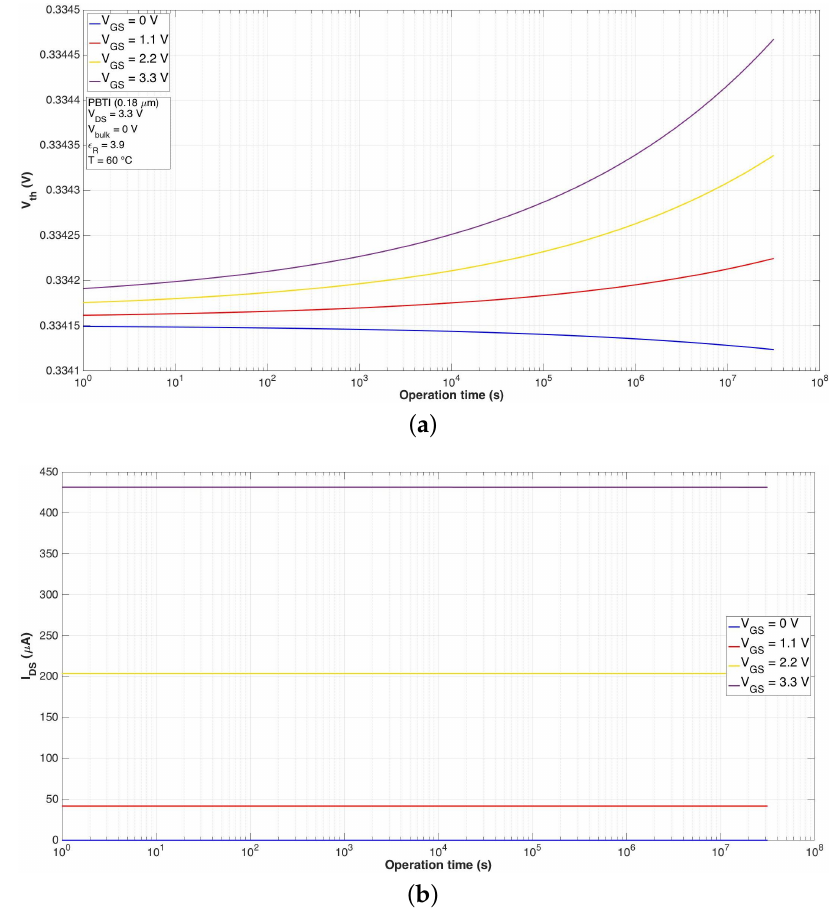
Figure 16. Simulation results for BTI into nMOS I-V curves, ( a ) threshold voltage, and ( b ) drain current degradation for one year of continuous